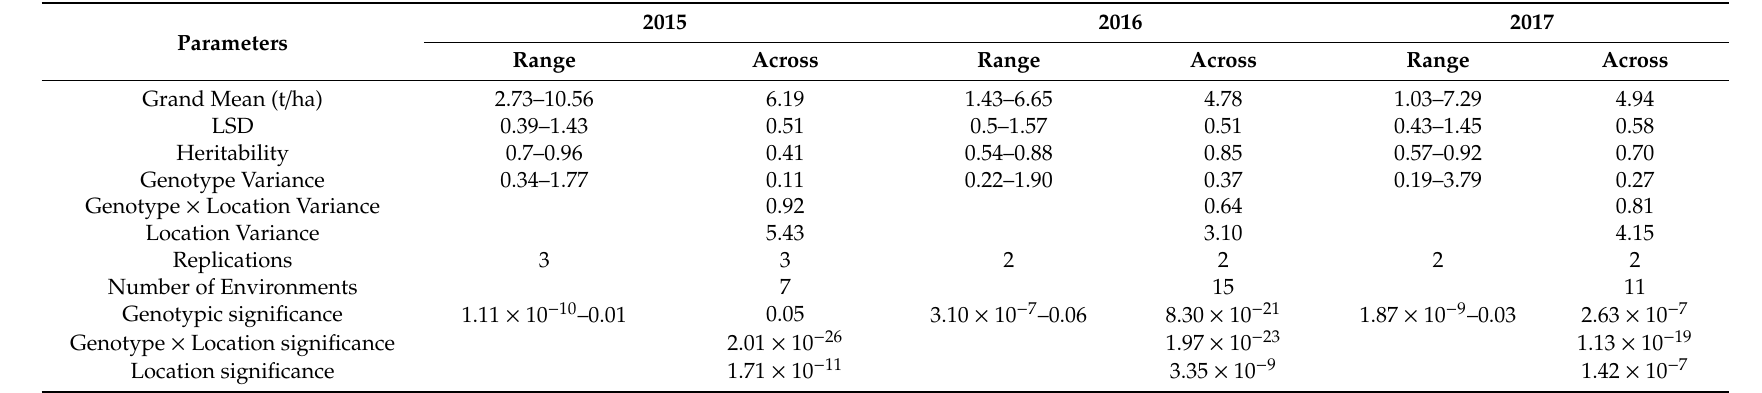
Table 2. Variance components and statistics across three trials evaluated during spring season of 2015 to